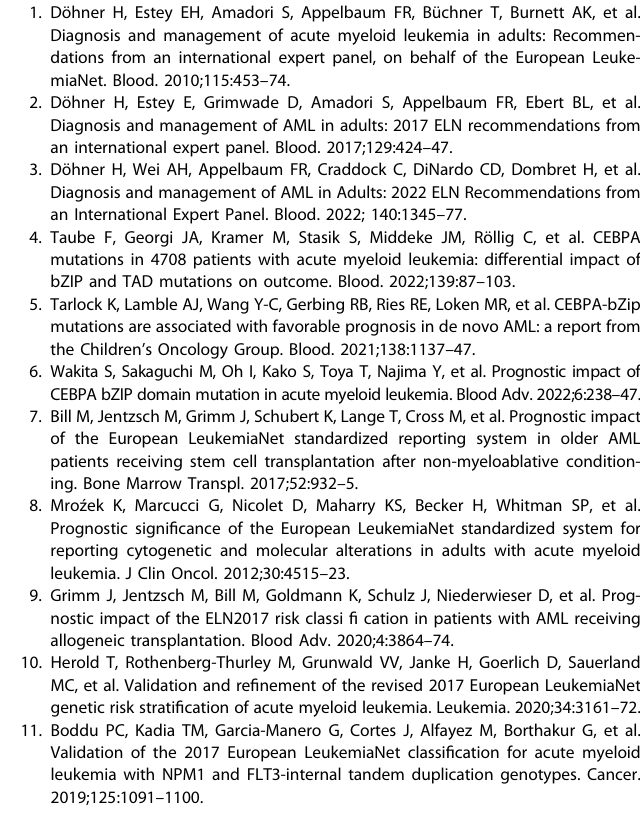
Fig. 5 Outcomes according to the proposed re fi nement of the ELN2022 risk groups at diagnosis and MRD-adjusted at HSCT. A Transition plot for patients distribution from the ELN2022 at diagnosis risk to the ELN2022 refined or death) within 1 year after HSCT between the ELN2022 at diagnosis and the ELN2022 refined three ELN2022 refined risk groups, D Transition plot for patients distribution from the ELN2022 MRD (cid:1) adjusted risk to the ELN2022 refined at diagnosis HSCT, E ROC curves comparison for suffering an event (relapse or death) within 1 year after HSCT between the ELN2022 MRD (cid:1) adjusted and the ELN2022 refined risk groups at HSCT, and F Event-free survival according to the three ELN2022 refined MRD (cid:1) adjusted